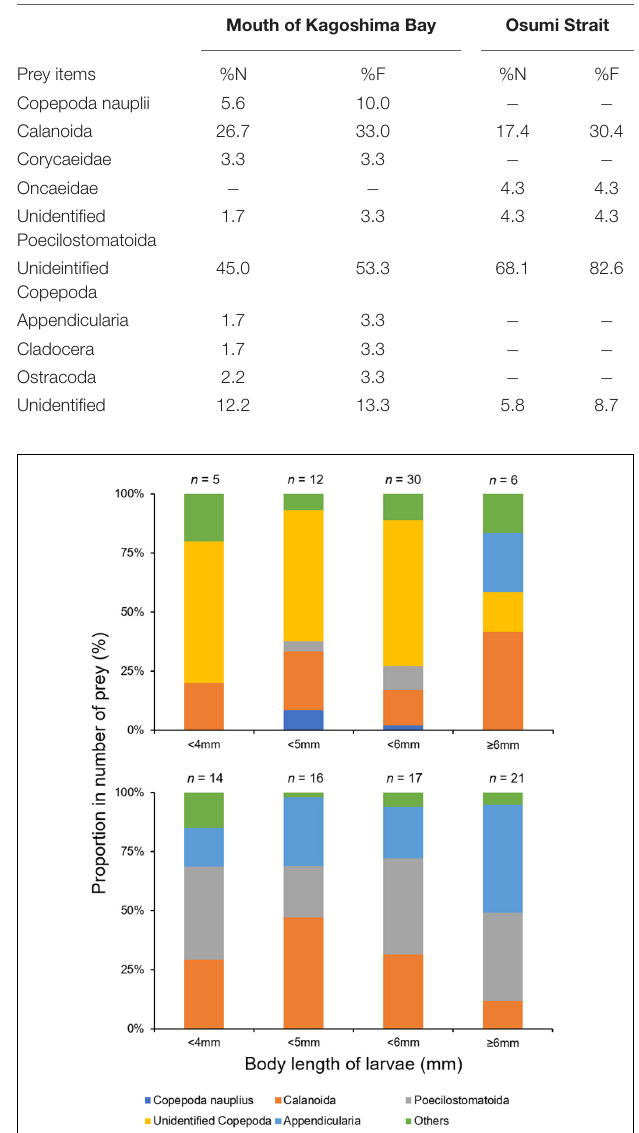
TABLE 3 | Percentage number (%N) and percentage frequency of occurrence (%F) of prey items in diet of Scomber japonicus larvae based on morphological analysis.